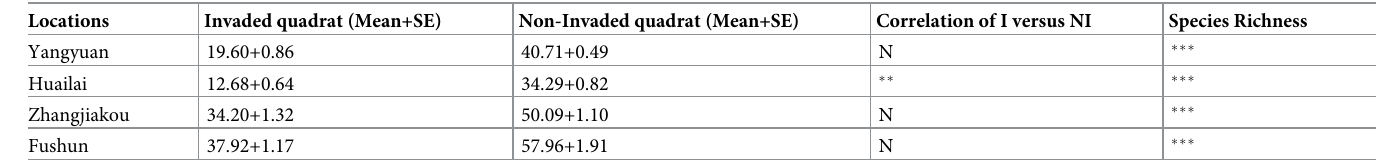
Table 1. Analysis of variance of the invasion impact on species richness among invaded and non-invaded quadrats at different locations. Locations Invaded quadrat (Mean+SE) Non-Invaded quadrat (Mean+SE) Correlation of I versus NI Species Richness Yangyuan 19.60+0.86 40.71+0.49 N ��� Huailai 12.68+0.64 34.29+0.82 �� ��� Zhangjiakou 34.20+1.32 50.09+1.10 N ��� Fushun 37.92+1.17 57.96+1.91 N ��� Whereas N = 30 (Number of quadrats 10 x 3 replication), I (Invaded), NI (Non-invaded); Mean + 1 SE �� , P < 0.01 ��� , P < 0.001, N, P >